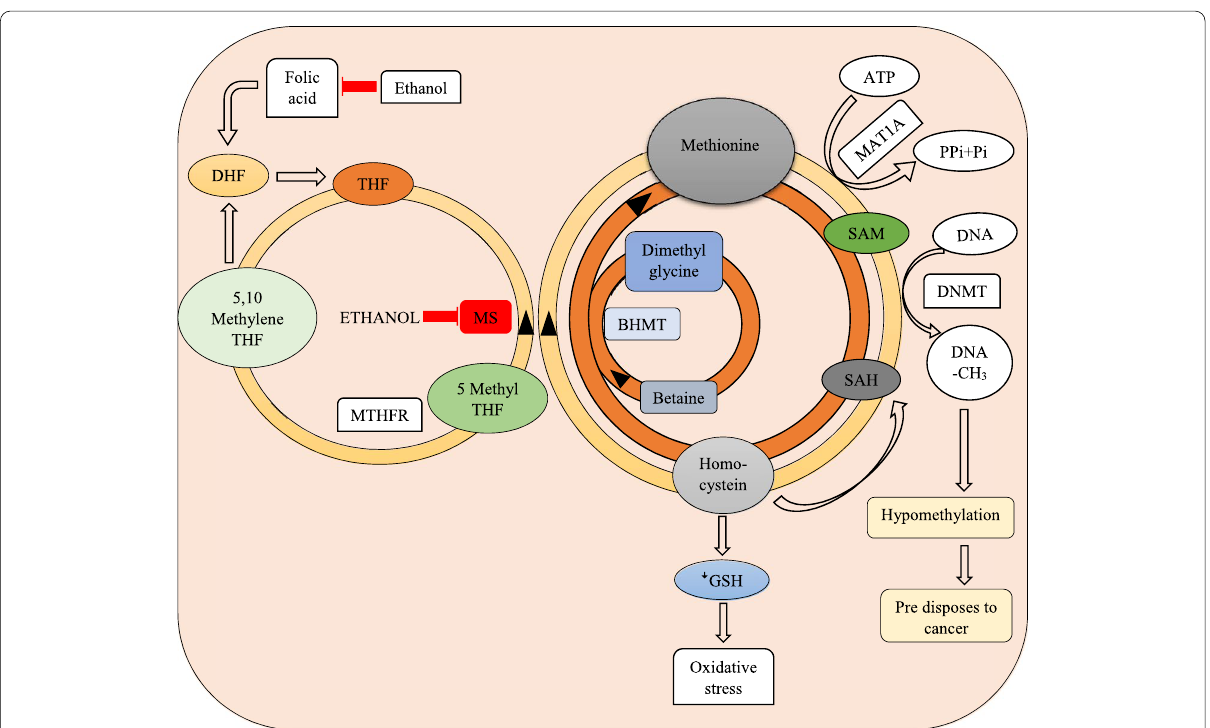
Fig. 9 Effect of alcohol on homocysteine/methionine metabolism and DNA methylation. In addition, alcohol disrupts the folate cycle involved in methionine metabolism, which is crucial to providing the methyl groups required for methylation of DNA. Folate is an essential nutrient for the production of DNA and a complicated folate cycle, including methylenetetrahydrofolate reductase